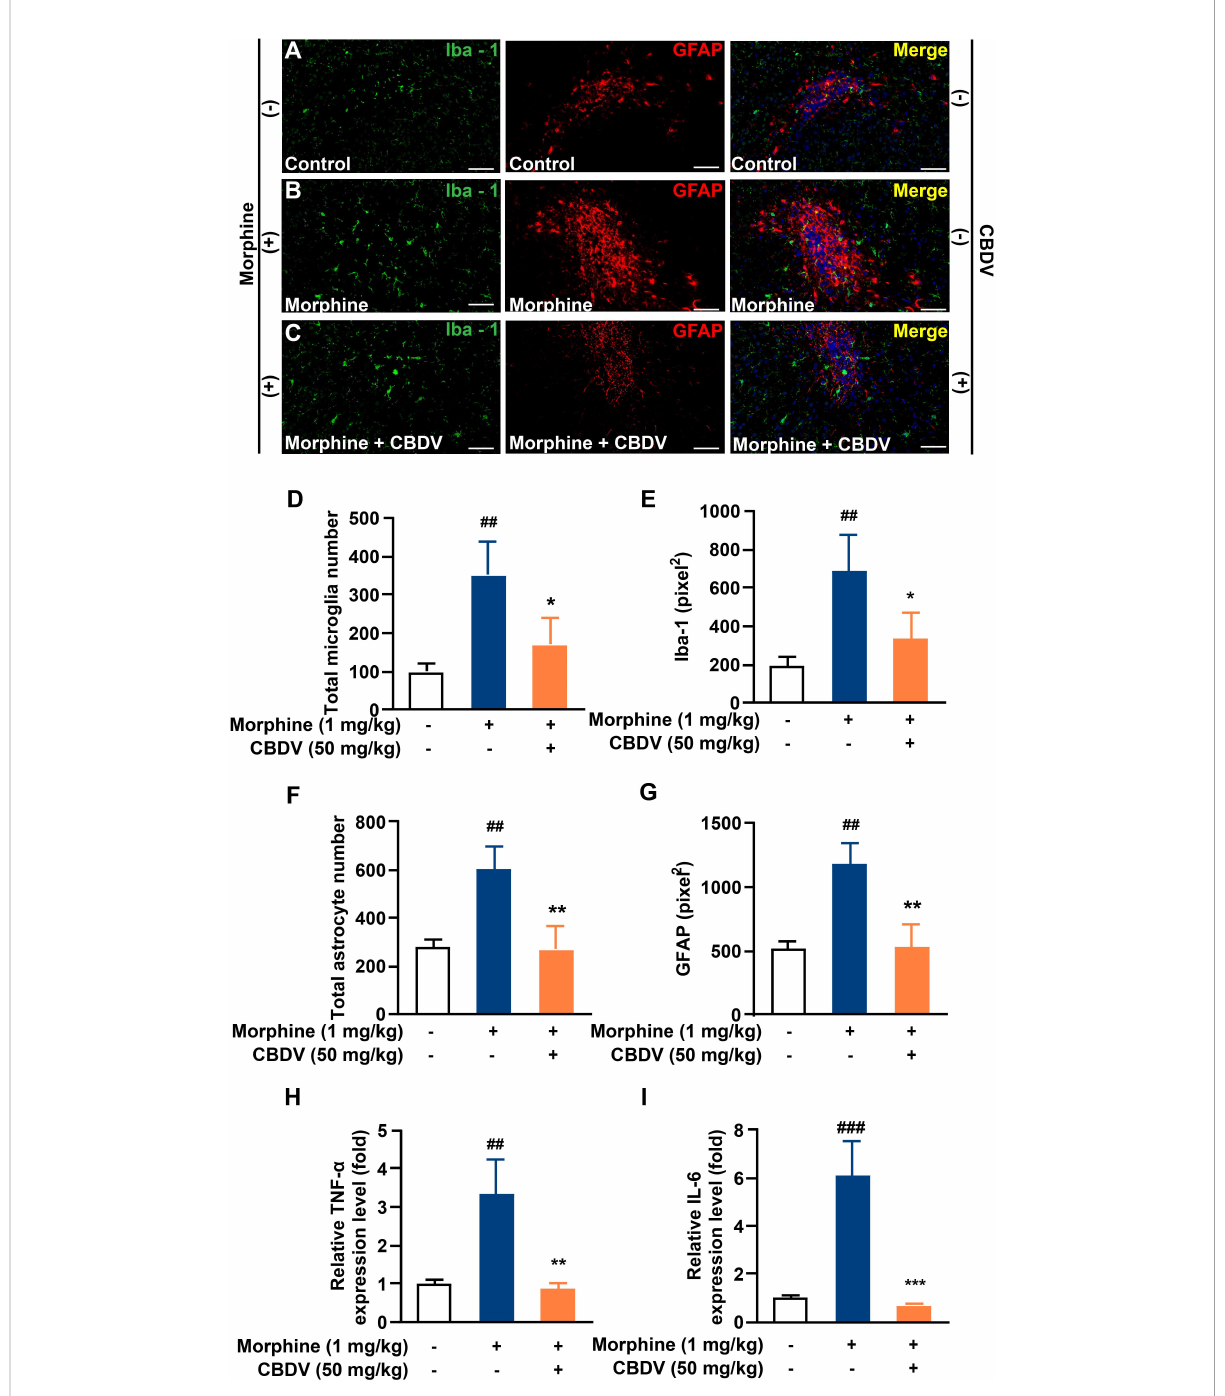
FIGURE 8 CBDV inhibits chronic morphine treatment-induced glial activation and pro-in fl ammatory factors IL-6 and TNF- a mRNA expression in NAc. (A – C) Representative double immuno fl uorescent staining images of Iba1 and GFAP for the control group (A) , morphine group (B) , and morphine + CBDV group (C) . NAc regions were collected following the fi nal behavioral testing shown in Figure 7B. (D, F) The quanti fi cation of microglia (D) and astrocytes (F) . (E, G) The size of the microglia (E) and astrocytes (G) . (H, I) Total RNAs were extracted and qRT-PCR was performed to measure the expression of TNF- a (H) and IL-6 (I) in NAc. Scale bar: 200 m m. All the data represented mean ± S.E.M. ## P < 0.01, ### P < 0.001 versus the control group; *P < 0.05, **P < 0.01, ***P < 0.001 versus the morphine